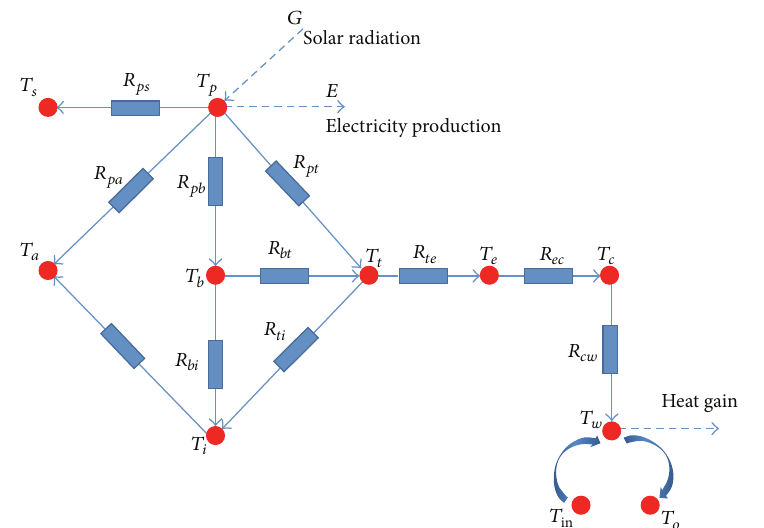
Figure 3: Energy flow at PV-HP